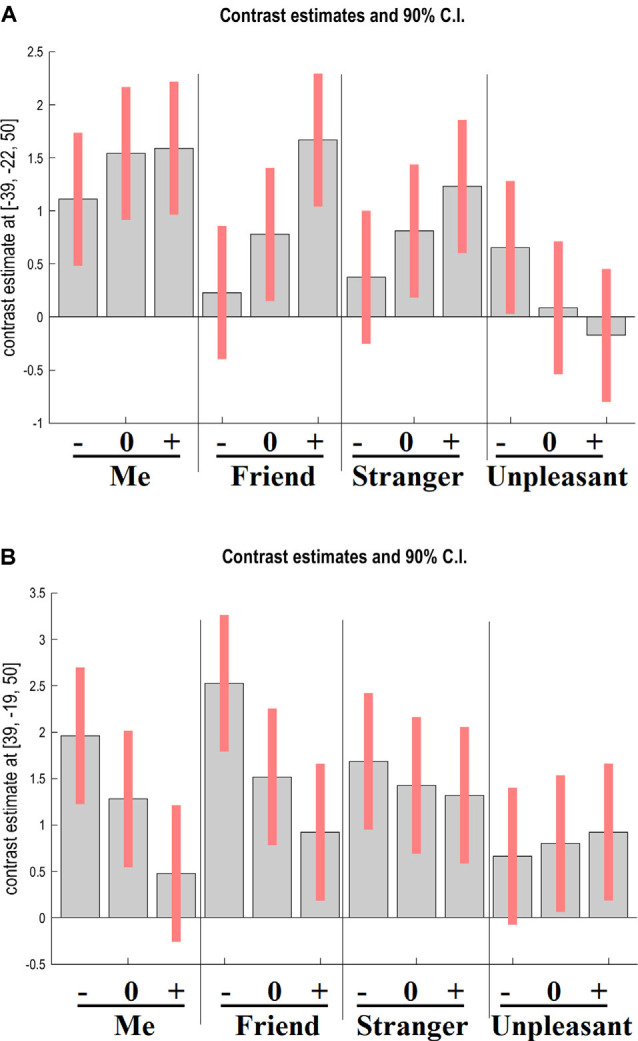
GLM results. The interaction between target and adjective valence. Contrast estimates and 90% confidence intervals for BOLD activation in the left postcentral gyrus (A) and the right precentral gyrus (B) during the four experimental tasks upon presentation of negative (−), neutral (0), and positive (+) adjectives. Note that activation of the left sensorimotor area reflects the tendency to respond “Yes” (i.e., to press the right-hand button), whereas activation of the right sensorimotor area reflects the tendency to respond “No” (i.e., to press the left-hand button).